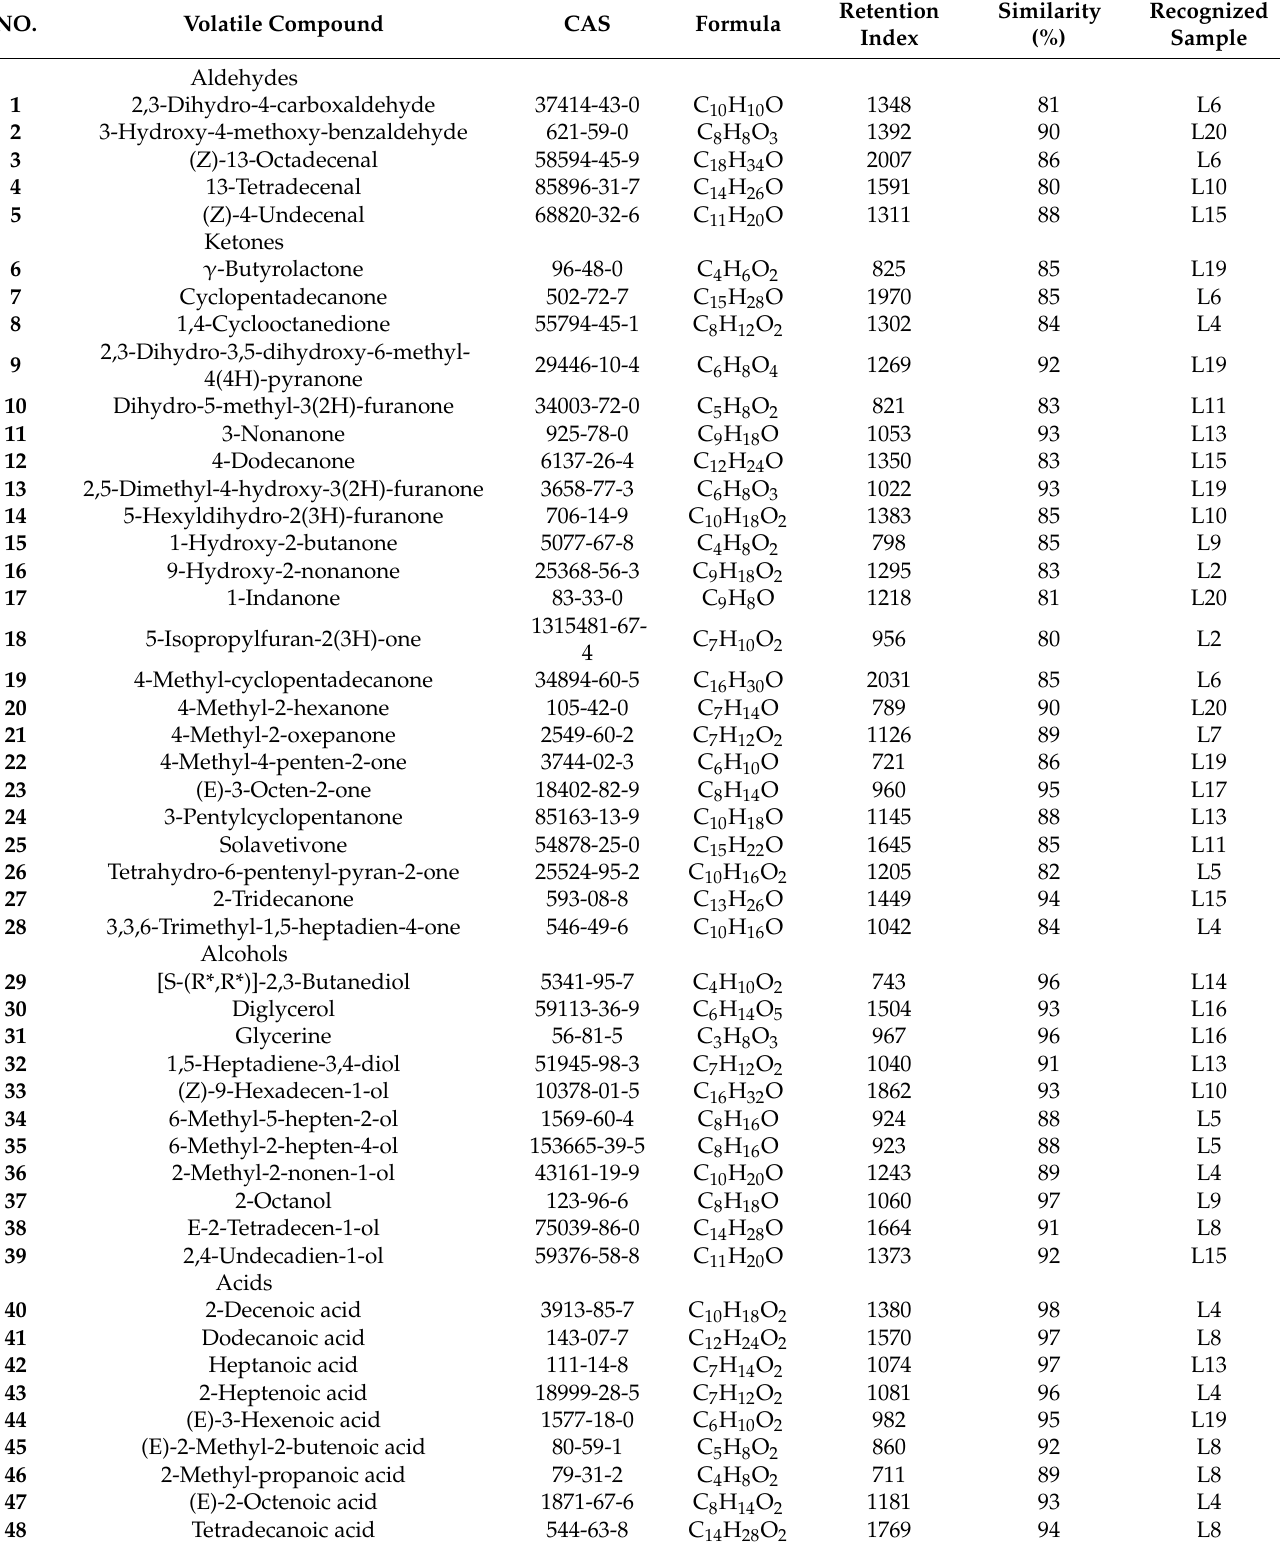
Table 2. Information of unique volatile compounds of VCO from 20 geographic